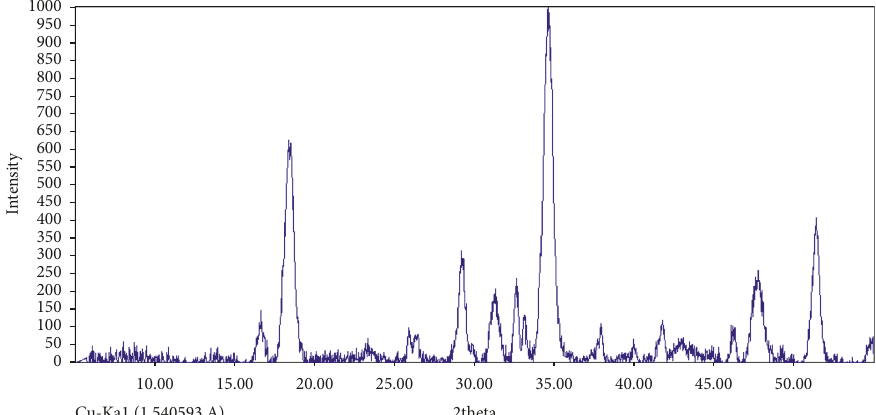
Figure 2: X-ray diffraction of β -wollastonite.